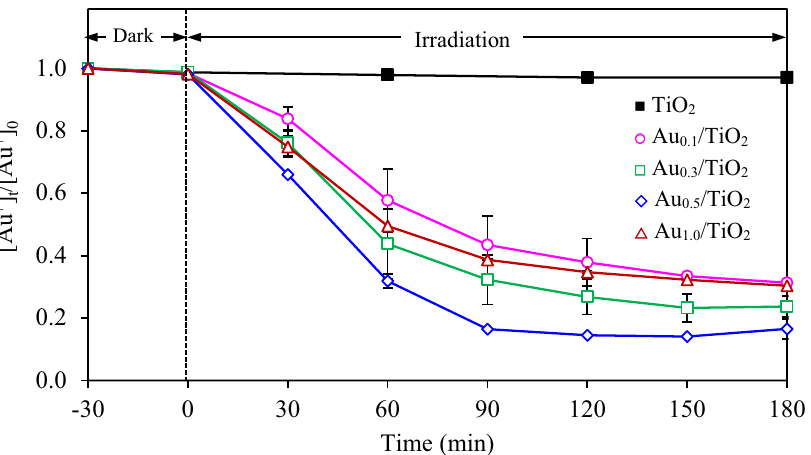
Figure 9. Variation of gold recovery via different Au x /TiO 2 photocatalysts at dosage of 2 g/L and light intensity of 3.20 mW/cm 2 in the absence of hole scavenger.